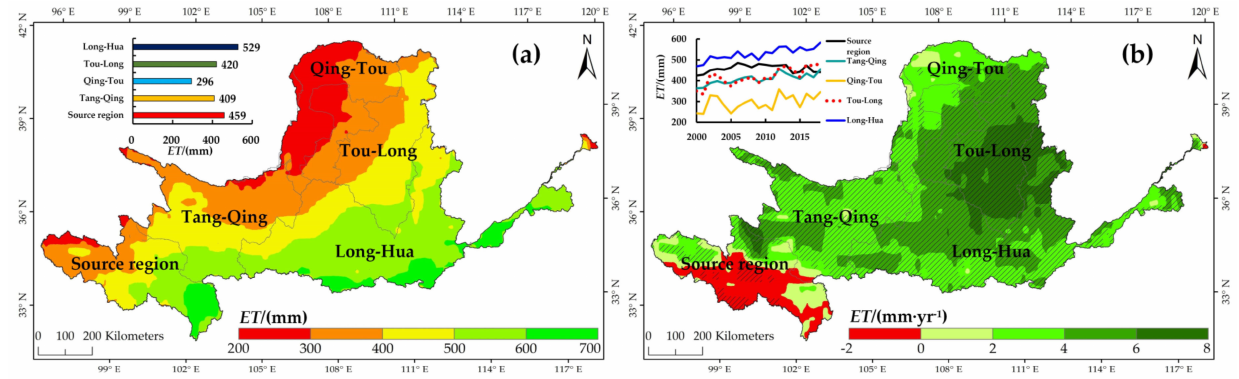
Figure 5. ( a ) Spatial distribution of the multi-year average ET, and the ( b ) interannual trend of the ET in the YRB from 2000 to 2018. Regions that lie within the pattern of diagonal lines represent areas with significant trend ( α <